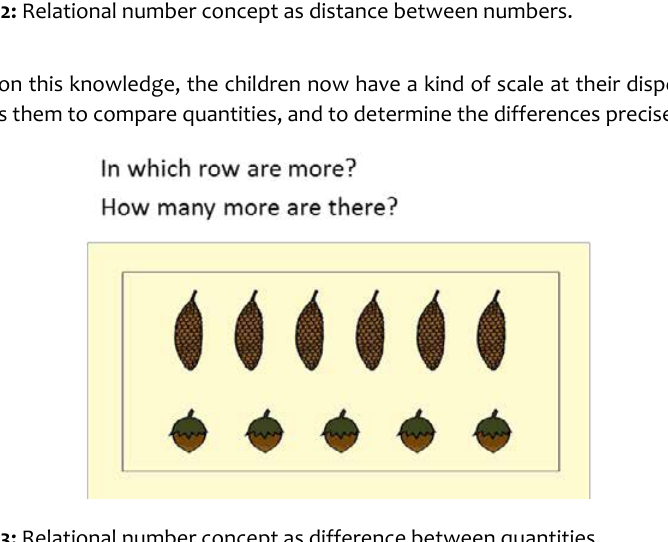
Figure 2: Relational number concept as distance between numbers.